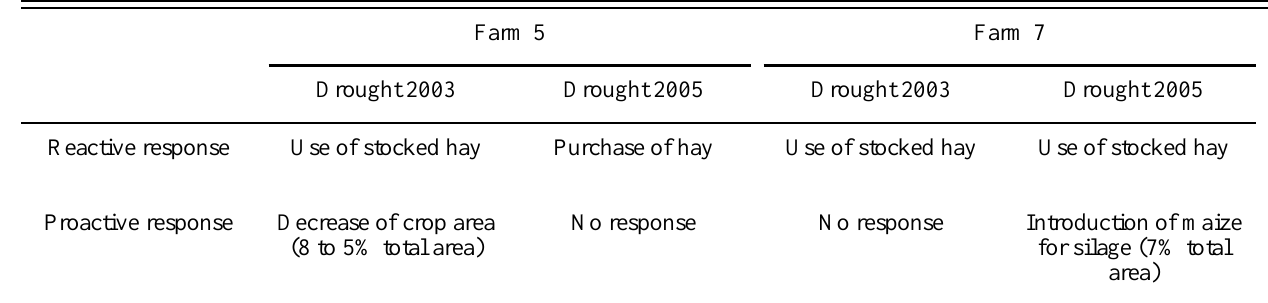
Table 4. Timing and extent of change to deal with drought for two of the farms